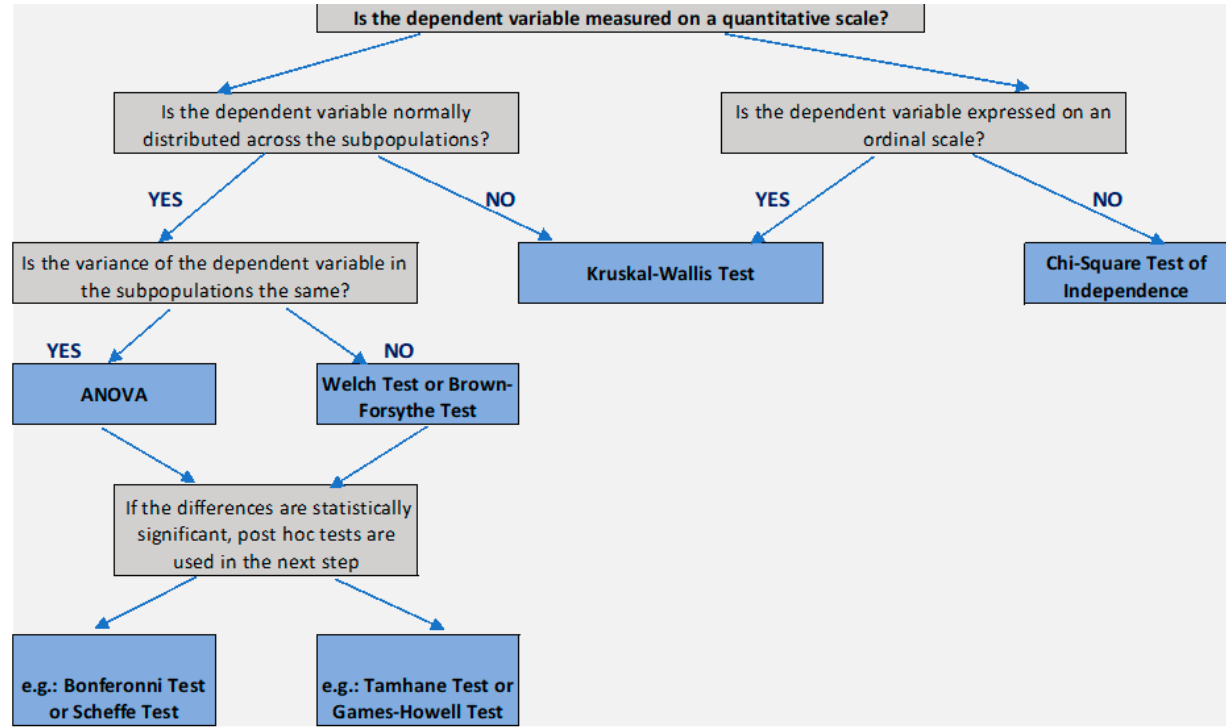
Figure 2. Diagram for selecting the appropriate test in the comparison of at least two populations— independent measurement. Source: own elaboration based on